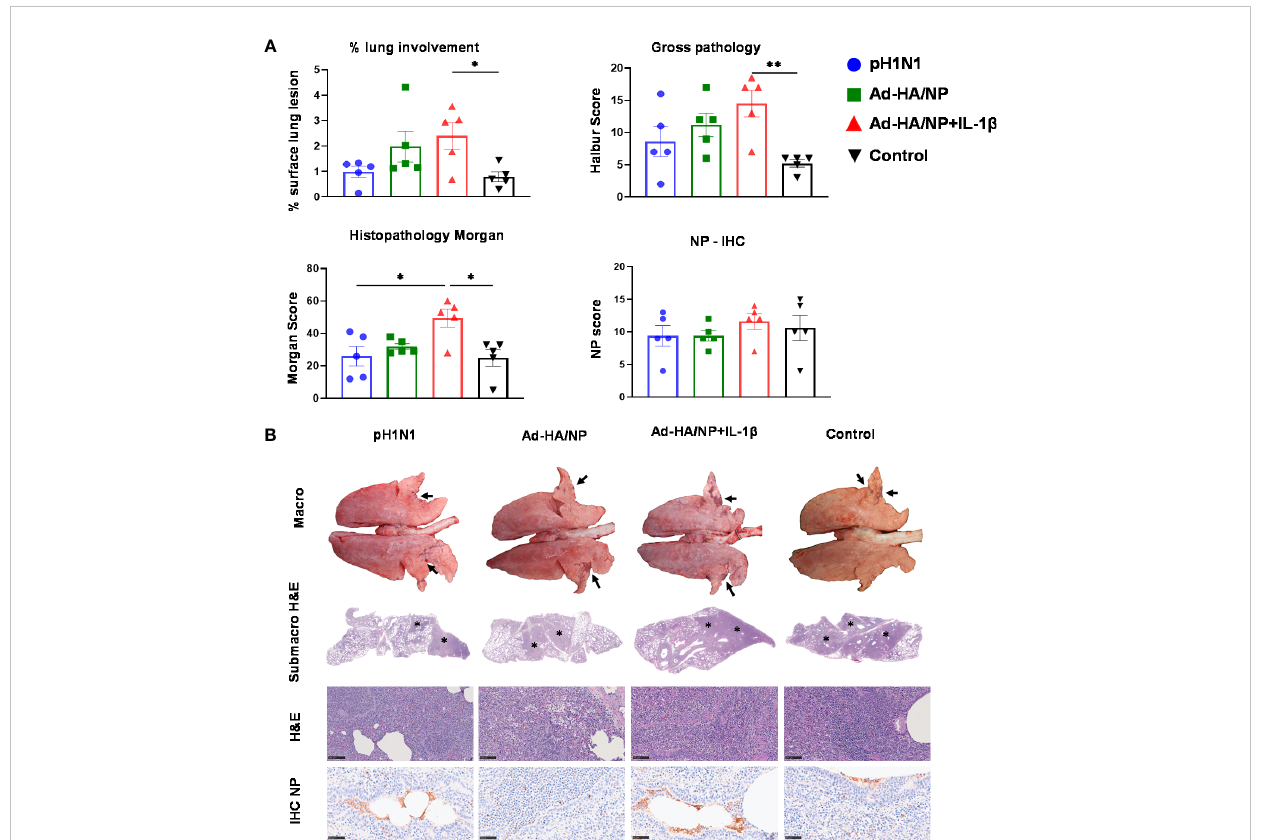
FIGURE 5 Pathological assessment of lung sections after heterologous challenge. Pigs were challenged with H3N2 28 days post pH1N1 infection or immunization with Ad-HA/NP or Ad-HA/NP+IL-1 b or control. Four days after the H3N2 challenge, the animals were culled and lungs were scored for the appearance of gross and histopathological lesions. (A) The gross and histopathological scores for each individual in a group and the group means are shown, including the percentage of lung surface with lesions, the lesion scores, and histopathological Morgan scores. (B) Representative lung gross pathology, histopathology (submacroscopic and microscopic), and immunohistochemical NP staining of each group. Gross pathology is observed as areas of consolidation (arrows). At submicroscopic histopathology, areas of bronchopneumonia are characterized by the obliteration of the normal airway structures, with in fl ammatory cell in fi ltration (*), that can be observed at the microscopic level as bronchiolo- and broncho- interstitial pneumonia with necrosis of epithelial cells and in fl ammatory in fi ltrates in the airways and parenchyma (*). Virus NP detected by IHC (brown stain, arrows) within the bronchiolar wall and luminae and occasionally within the parenchyma. Bar = 100 micrometers. Pathology scores were analyzed using one-way ANOVA followed by Tukey ’ s multiple comparison test. Asterisks denote signi fi cant differences **, p<0.01 and *, p < 0.05 versus the group indicated by the horizontal